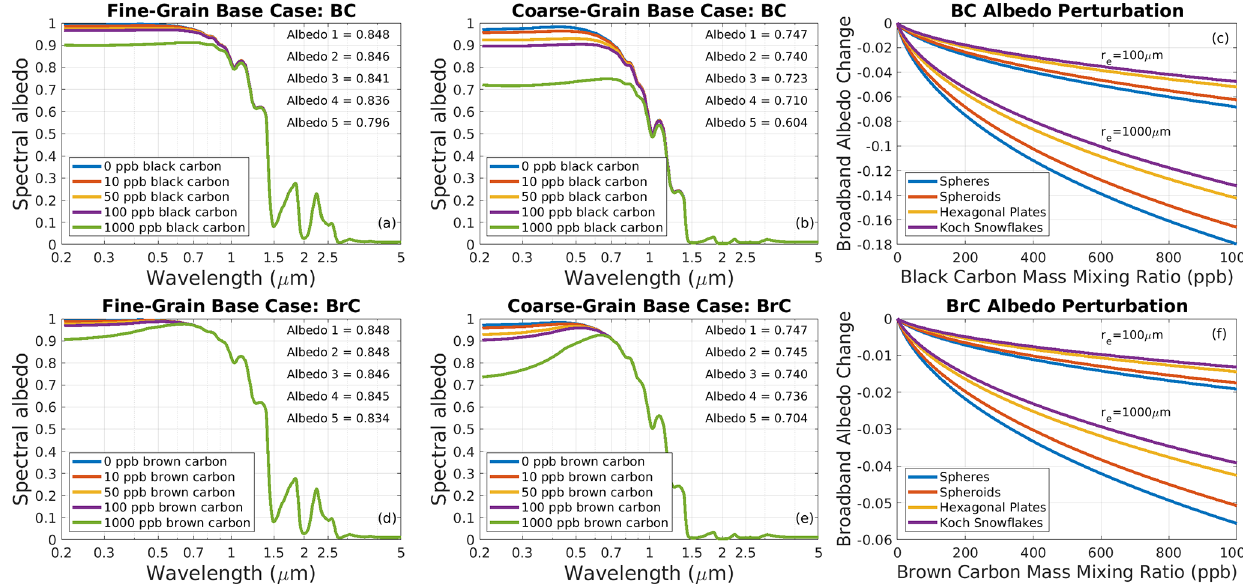
Figure 6. Albedo variations caused by uncoated black carbon (a–c) and brown carbon (d–f) . Spectral albedo perturbations for fine-grain ( a, d ) and coarse-grain ( b, e ) base cases are shown, as well as broadband albedo perturbations as a function of LAC content ( c, f ). The order of broadband albedos shown in each panel corresponds with the legend